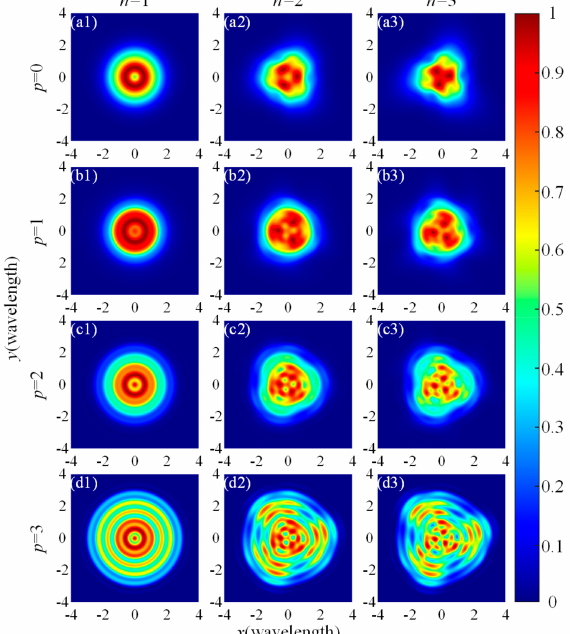
Figure 3. The normalized intensity distribution of different power exponents n and radial index p ( l = 3, δ = 0.005 m, and p ’ = 1). When the radial index p is 0 to 3, the total intensity distribution of ( a1 – d1 ) the power exponents n = 1, ( a2 – d2 ) the power exponents n = 2, and ( a3 – d3 ) the power exponents n =